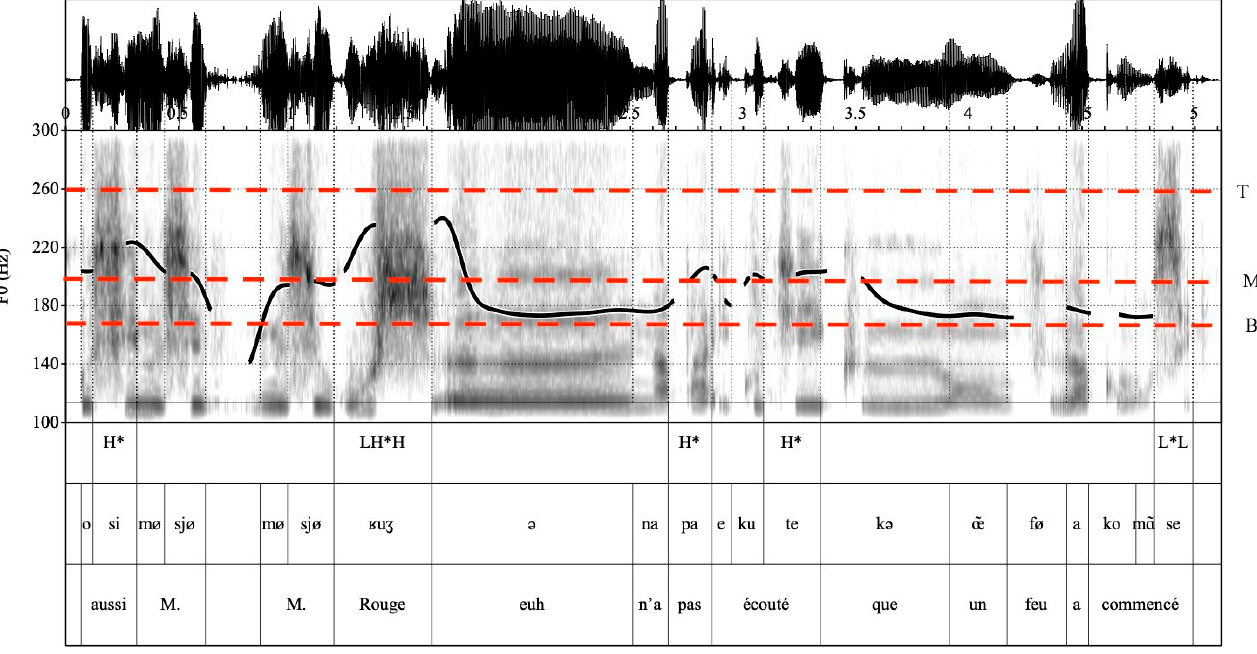
Figure 10. Additive utterance in French L2 with initial aussi (8-INT sbj 12). Accented syllables are indicated with *.